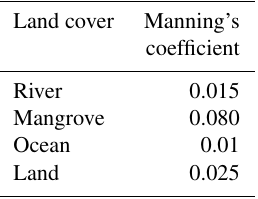
Table 1. Manning’s roughness coefficient for different land